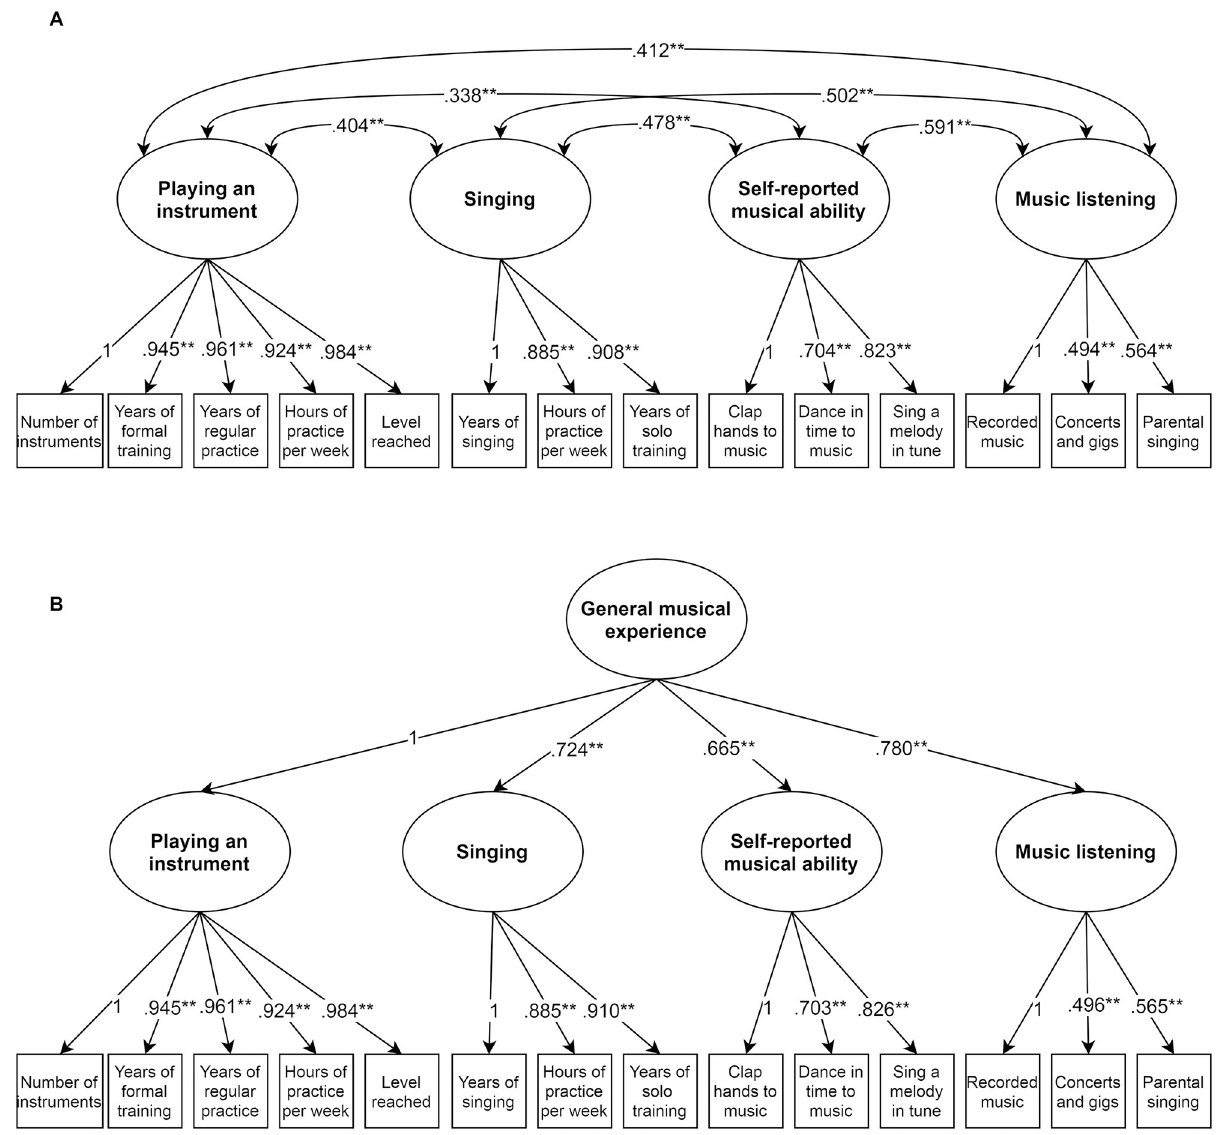
Fig 3. Model of musical experience latent variables and their correlations (panel A) and a higher-order model of general musical experience (panel B). Ellipses represent latent variables, rectangles observed variables, double headed arrows correlations and single headed arrows factor loadings. All path estimates are standardized. �� p <